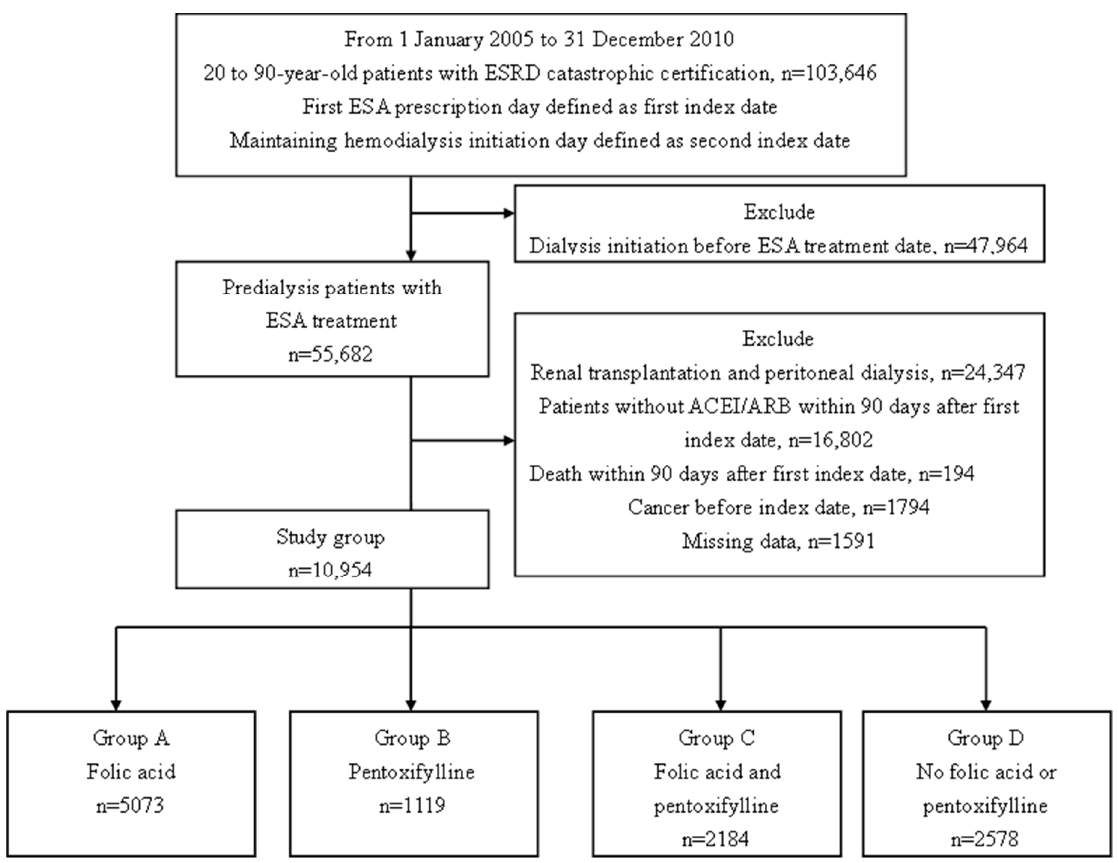
Figure 1. Patient selection flowchart. Abbreviations: ACEI, angiotensin-converting enzyme inhibitor; ARB, angiotensin II receptor blocker; ESRD, end-stage renal disease; ESA, erythropoiesis-stimulating agent. Table 1. Baseline characteristics